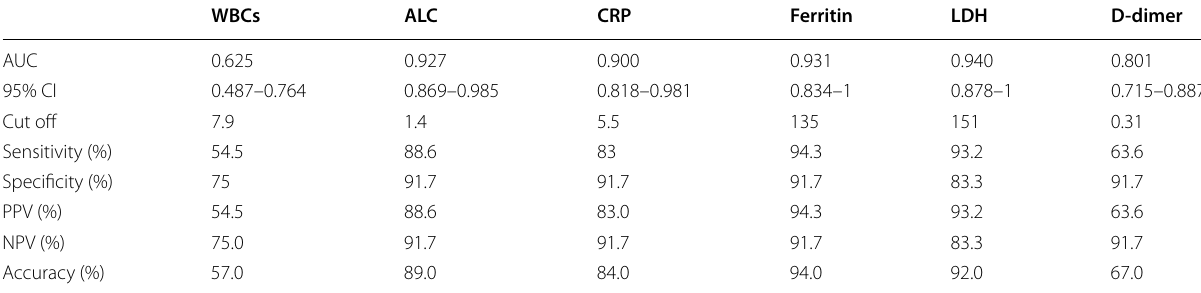
Table 7 Validity of TLC, ALC, CRP, ferritin, LDH, and D‑dimer for discrimination between negative and positive CT